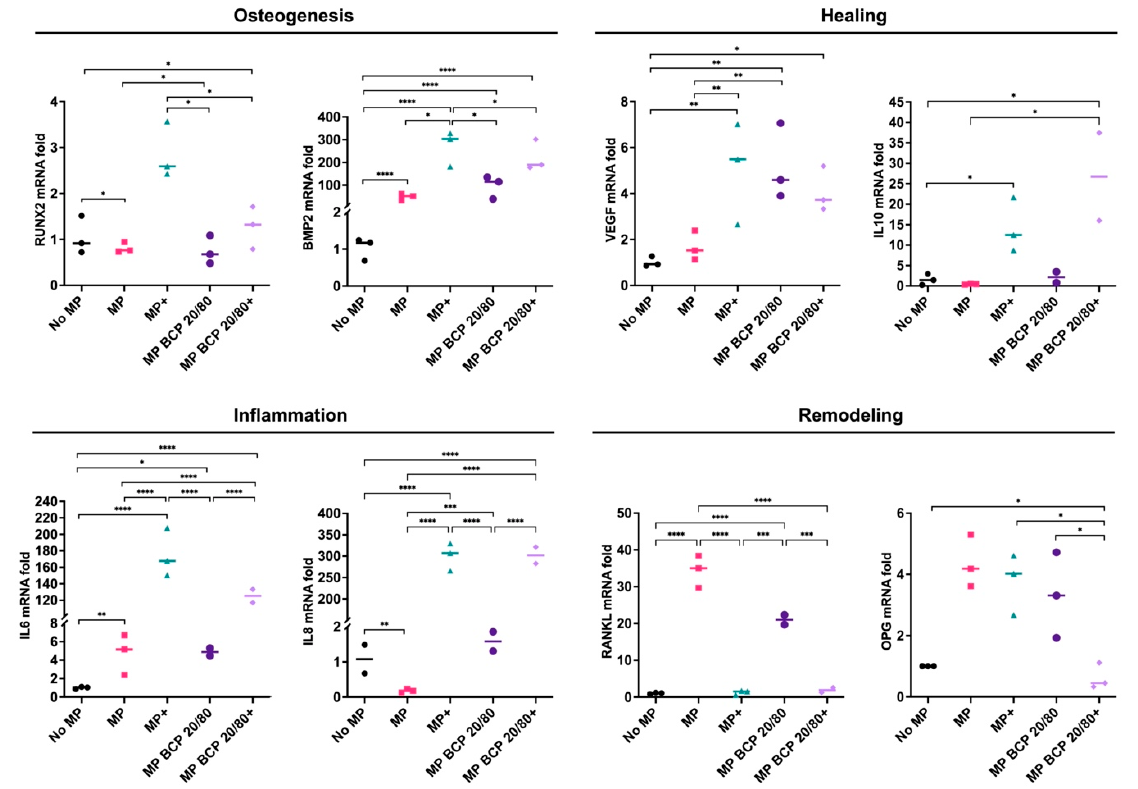
Figure 6. Relative mRNA expressions (fold changes) of osteogenesis-, healing-, inflammation- and remodeling-related genes in MSCs cultured with BCP 20/80 and/or MPs (n = 3). No MP, monolayer MSC control; MP, monolayer MSCs cocultured with MPs; + represents cytokine stimulation. Statistical analyses are based on one-way ANOVA with Tukey’s multiple comparison tests on delta-Ct values; * p < 0.05; ** p < 0.001; *** p = 0.0001; **** p < 0.0001.